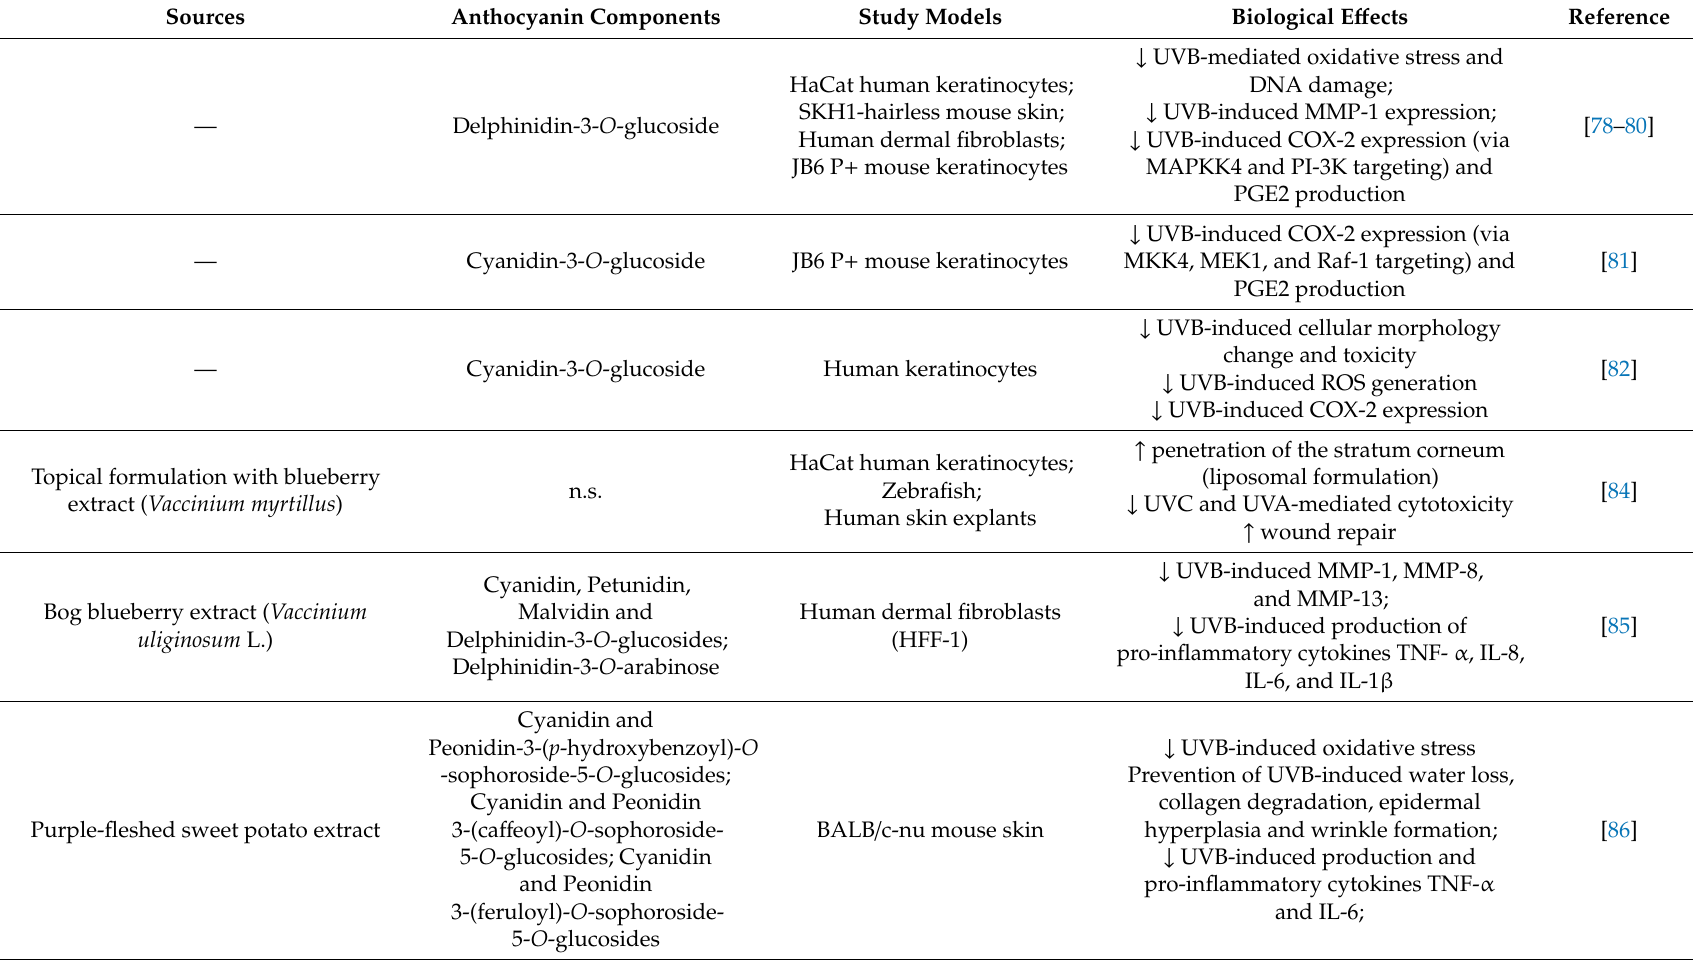
Table 1. Summary of the photoprotective e ff ects of anthocyanins in di ff erent